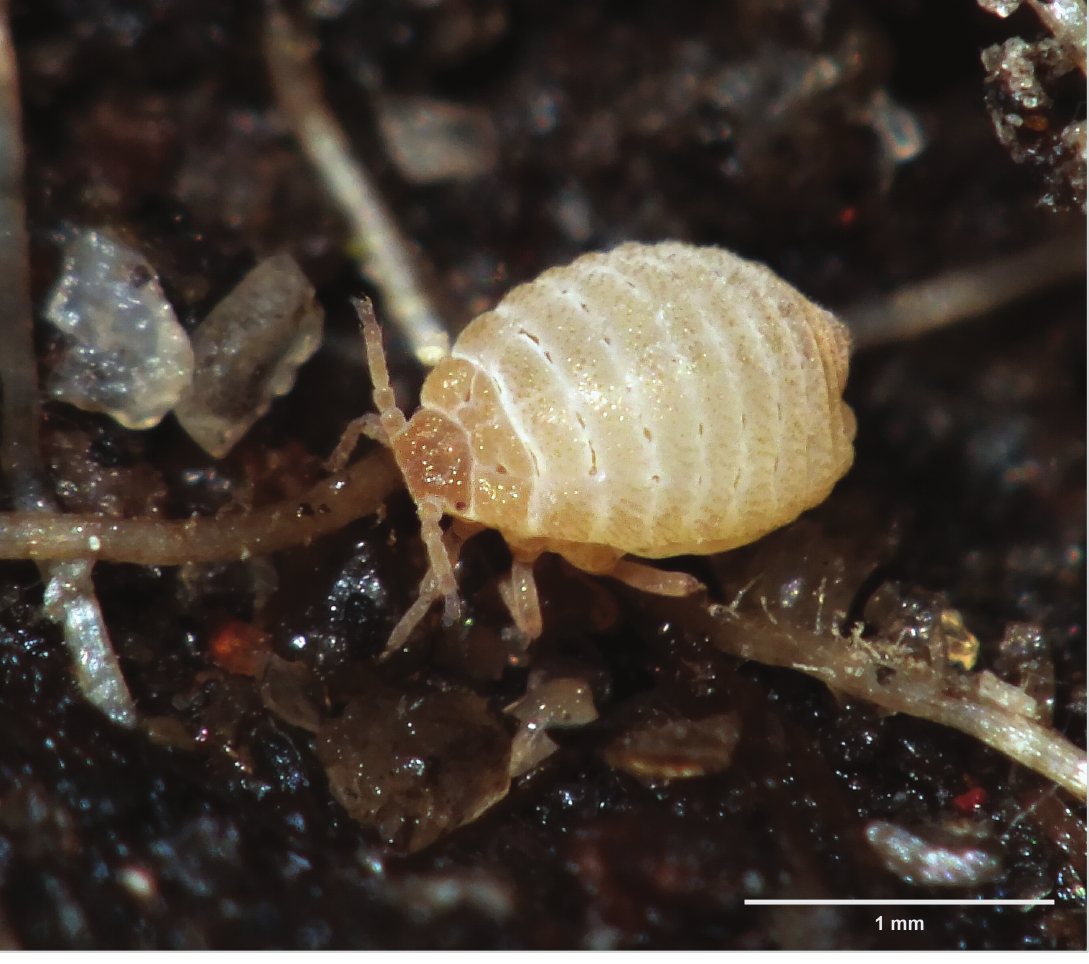
Fig. 17. Geoica utricularia (Passerini, 1856) . Apt. on grass